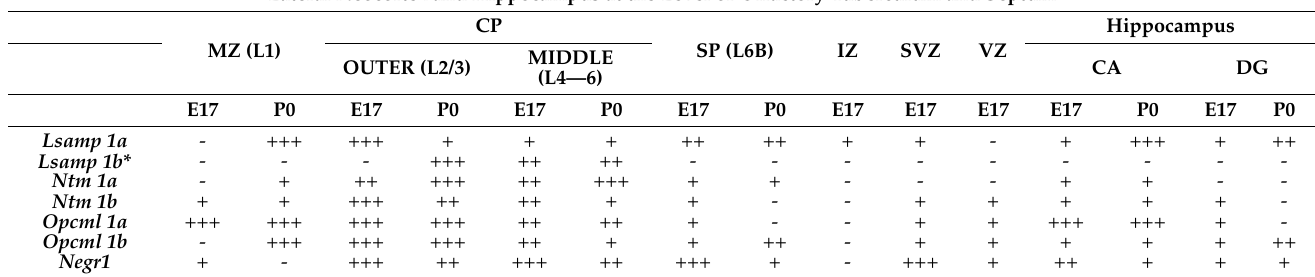
Table 1. Relative abundance of IgLON transcripts in developing cortex and hippocampus at E17 and P0. Expression abundance is determined after mRNA hybridization by visual observation as +—weak; ++—moderate; +++—strong; —-absent. Relative abundance is not comparable between different transcripts. Lsamp 1b *—X-Gal staining. Abbreviations: CA, cornuammonis ; CP, cortical plate; DG, dentate gyrus; IZ, intermediate zone, MZ, marginal zone; L, presumptive cortical layers; SVZ, subventricular zone; SP, subplate; VZ, ventricular